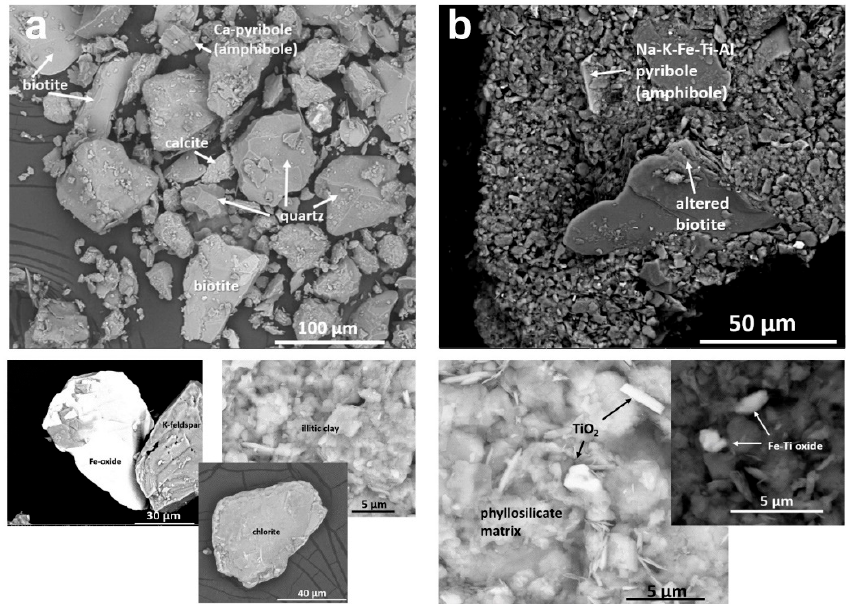
Figure 5. SEM (Scanning Electron Microscope) images of dust filters collected from ( a ) GS (T50) and ( b ) GP (T309).